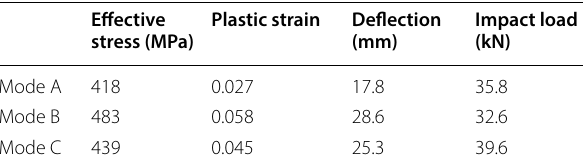
Table 3 Lists of the maximum values in three modes according to numercial simulationss (aluminium alloy by machining)